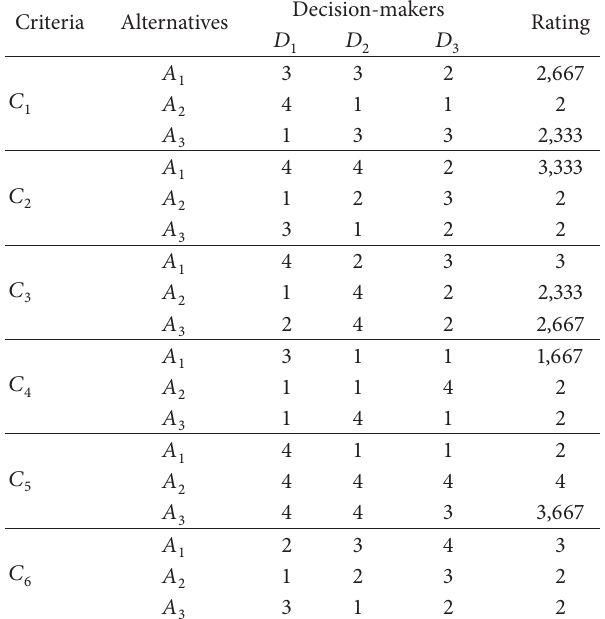
Table 7: The decision matrix.